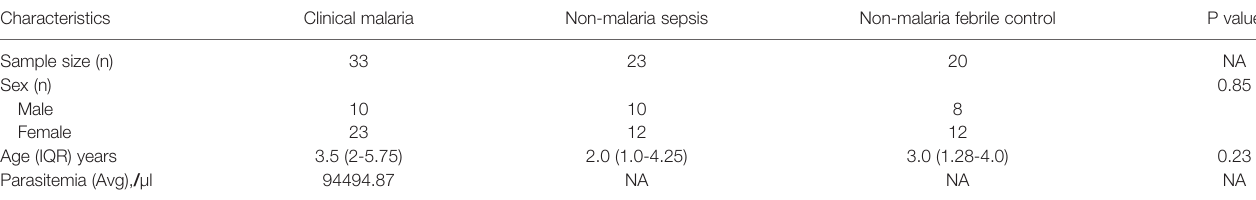
TABLE 1 | Demographics of study participants.